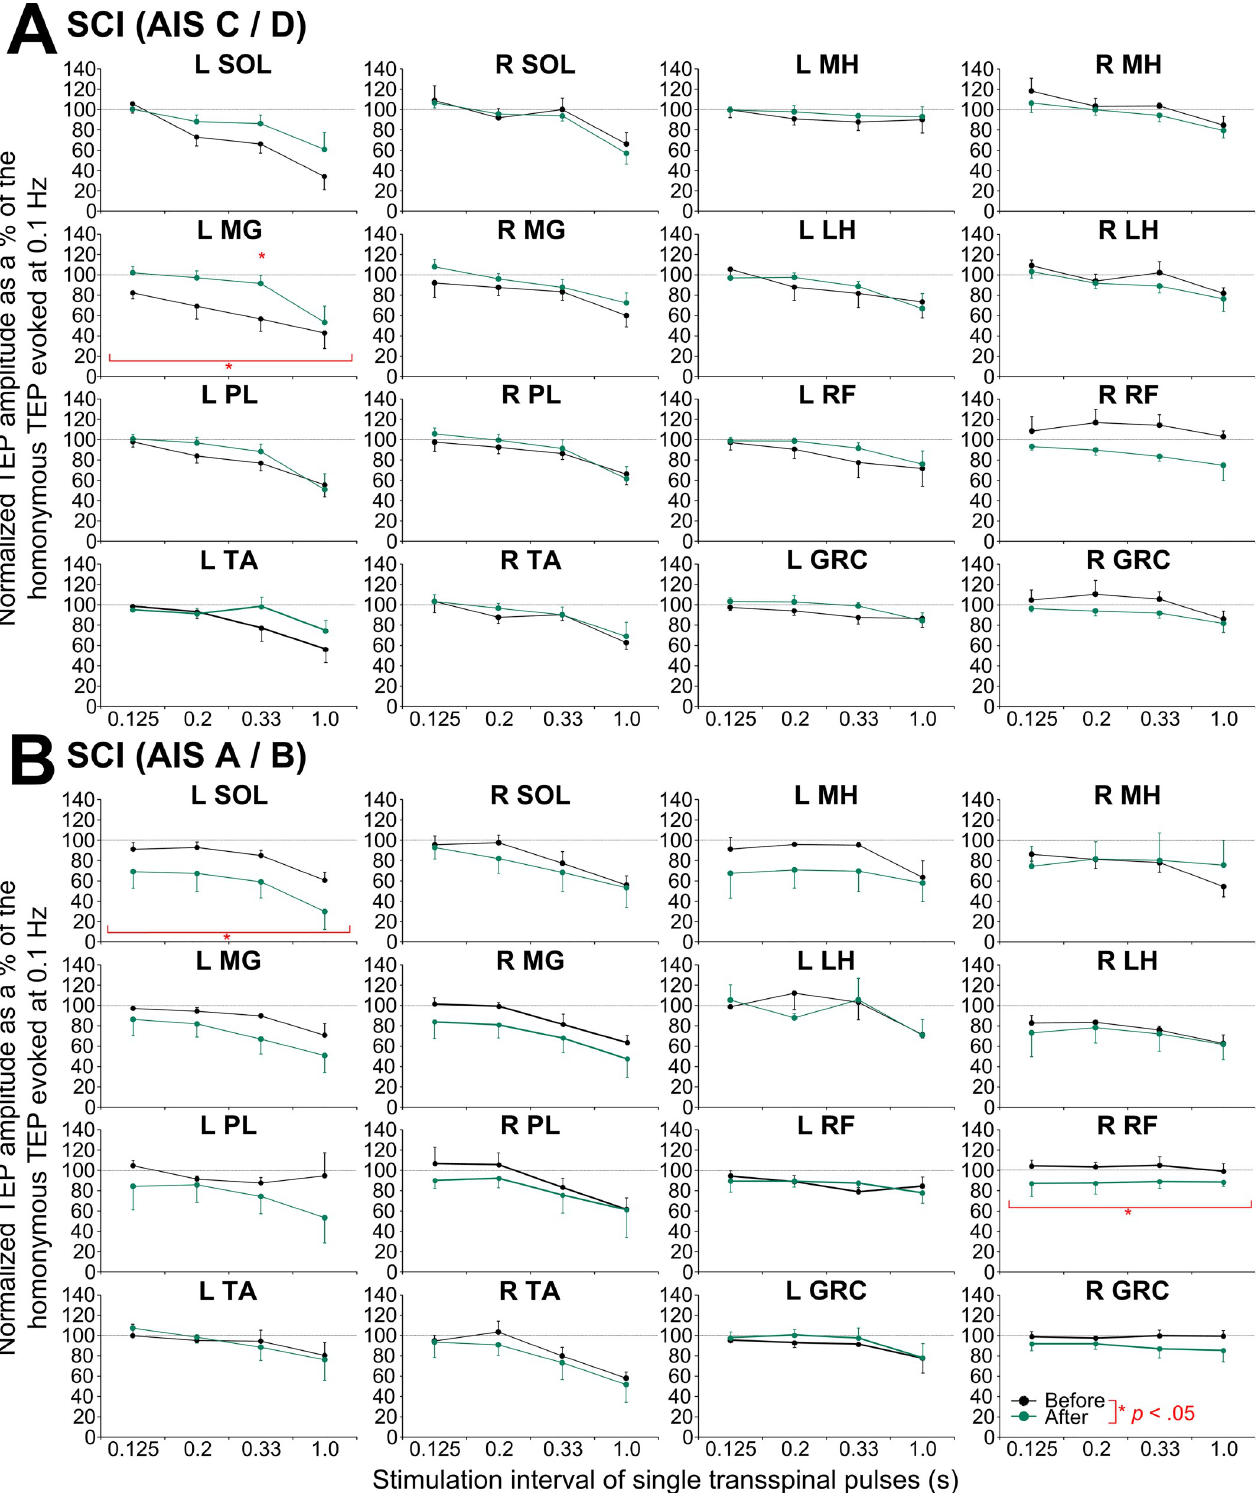
Fig 5. Homosynaptic transspinal evoked potential (TEP) depression before and after transspinal stimulation in spinal cord injury (SCI). Overall percent change of TEPs recorded at 0.125, 0.2, 0.33 and 1.0 Hz from the associated TEP recorded at 0.1 Hz before (black lines) and after (green lines) transspinal stimulation training in individuals with (A) AIS C-D and (B) AIS A-B. SOL: soleus; MG: medial gastrocnemius; TA: tibialis anterior; PL: peroneus longus; MH: